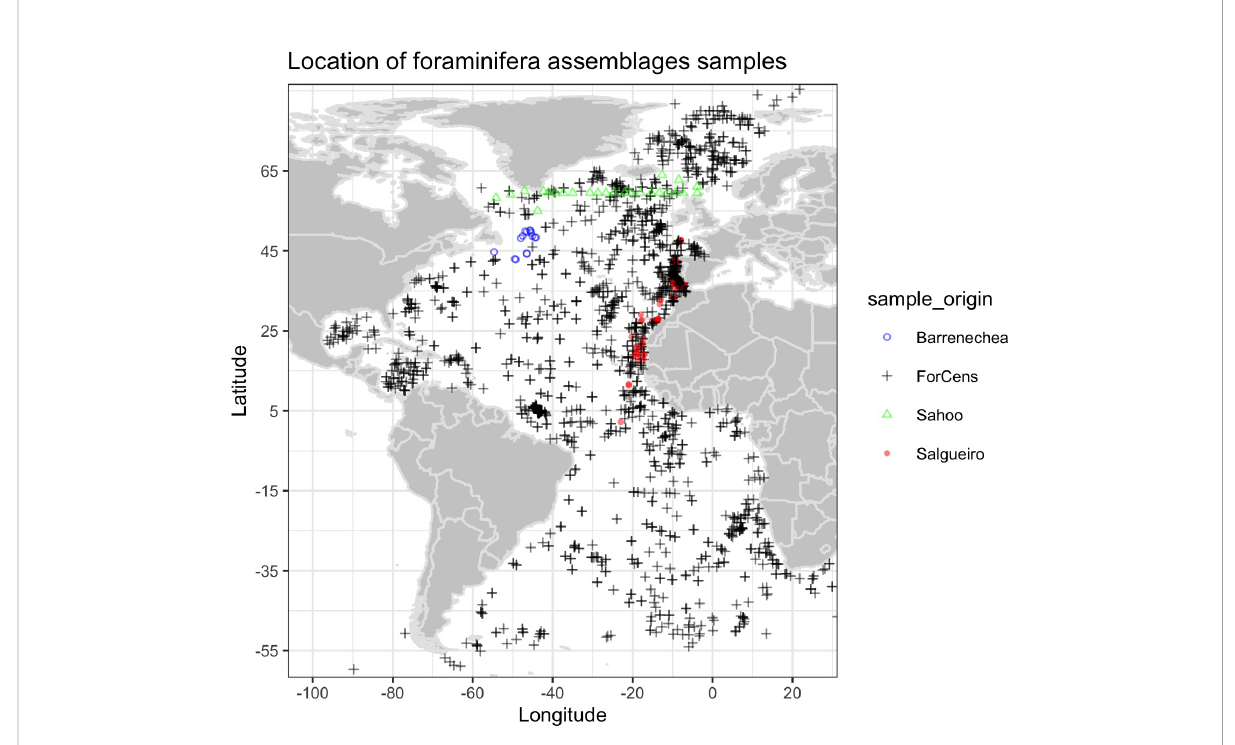
FIGURE 1 Map with location of the used sediment